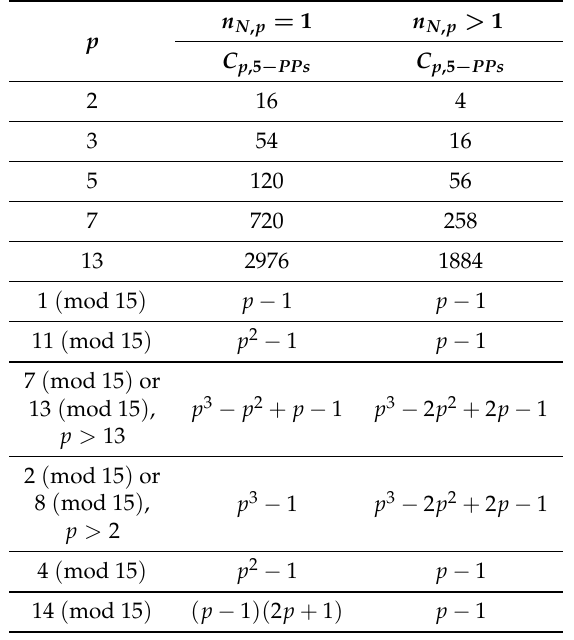
Table 3. The number of all fifth-degree permutation polynomials (5-PPs) over Z p permuting Z with n N , p ≥